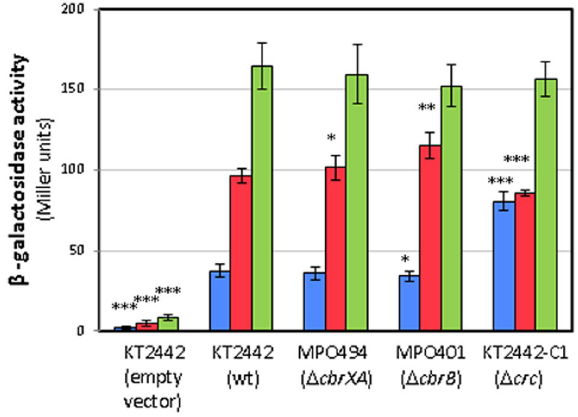
Figure 5. Expression levels of CbrA in a wild type, Δ cbrXA , Δ cbrB and Δ crc backgrounds. Expression was measured as β -galactosidase activity of a translational fusion of cbrA ’-‘ lacZ in plasmid pMPO1370 (coord. + 249) for the wild type (KT2442), Δ cbrXA (MPO494), Δ cbrB (MPO401) and Δ crc (KT2442-C1) strains. The assays were performed in LB medium (blue), minimal medium with succinate (red) or oxaloacetate (green) as carbon sources. pMPO200 empty plasmid was used as control. The values are the average of at least three independent assays, and error bars indicate the standard deviation of the means. Stars designate p-values for the Student’s t-test for unpaired samples not assuming equal variance. * :p < 0.05; ** p < 0.01; *** p <